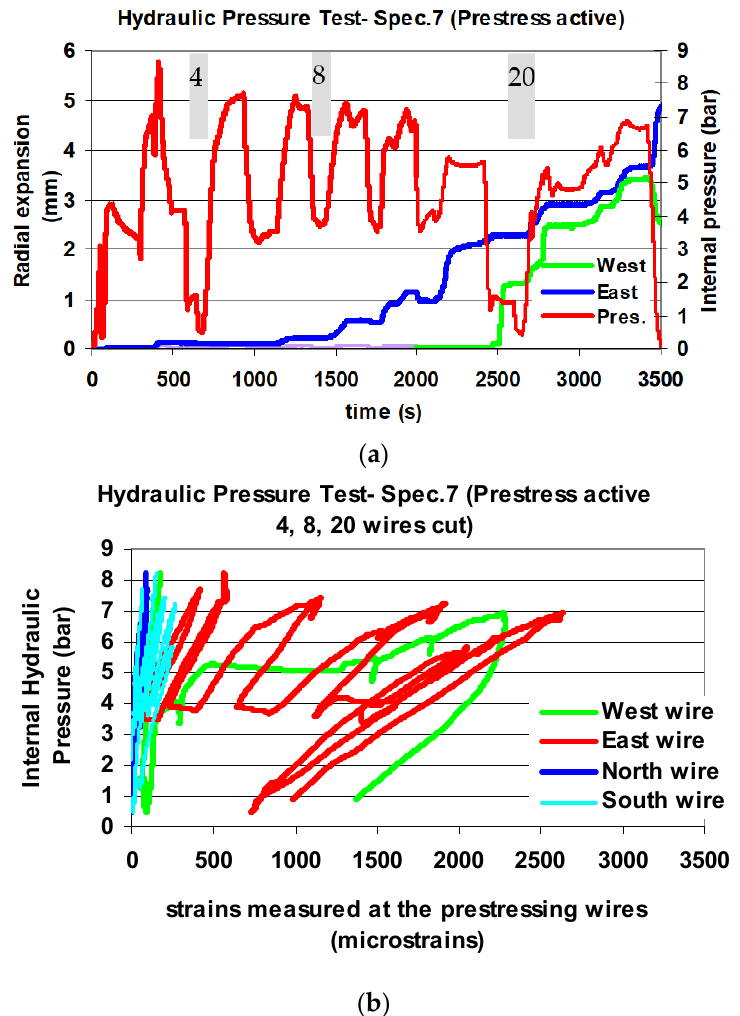
Figure 23. ( a ) Variation in radial expansion at East and West sections with the variation in internal pressure for the whole duration of the test. The time and the number of cut wires are also indicated with grey stripes. ( b ) Variation in wire radial strain versus internal pressure for the specimen with cut wires (4, 8 and 20).